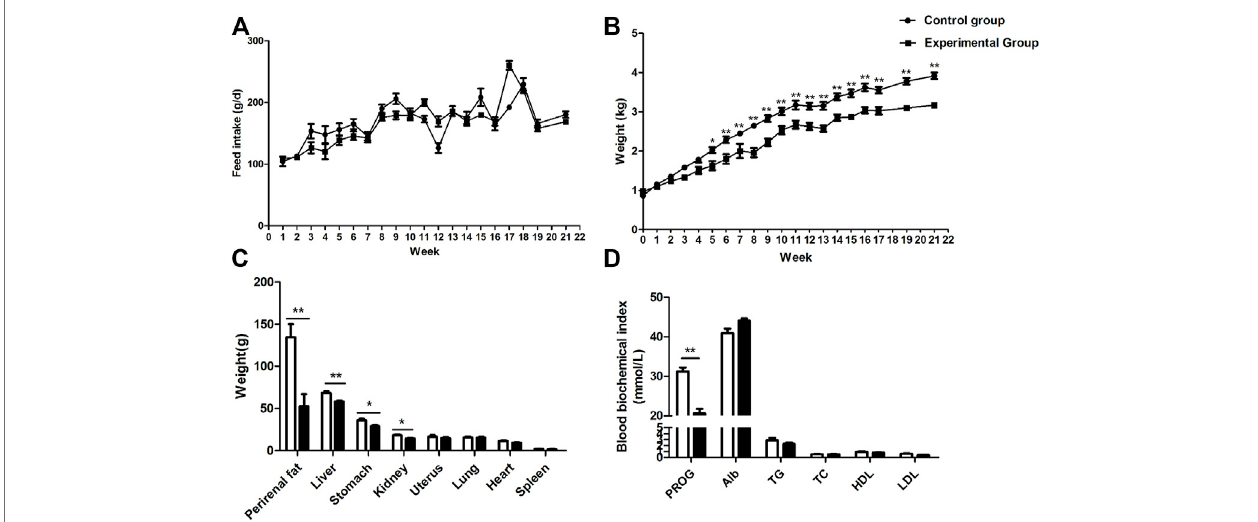
FIGURE 1 | Effects of coprophagy prevention on (A) feed intakes; (B) body weight; (C) weight of different tissues and internal organs; and (D) serum biochemical parameters in rabbits [progesterone (PROG), albumin (Alb), triglycerides (TG), total cholesterol (TC), HDL-cholesterol (HDL), and LDL-cholesterol (LDL)]. Statistical differences between groups were indicated as * for p < 0.05, ** for p < 0.01, and *** for p < 0.001.